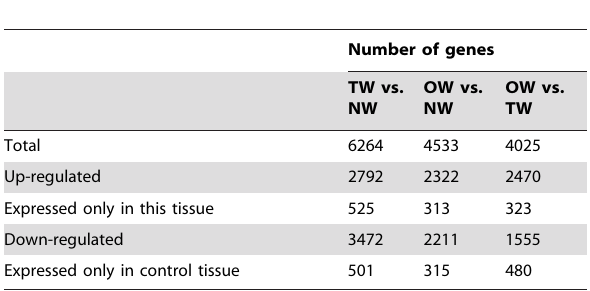
Table 3. The distributions of differentially expressed